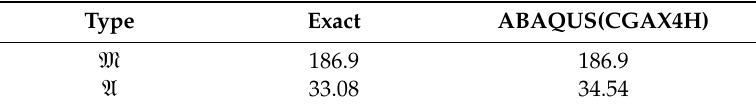
Table 7. Torque (kN · mm) and normal force (kN) of